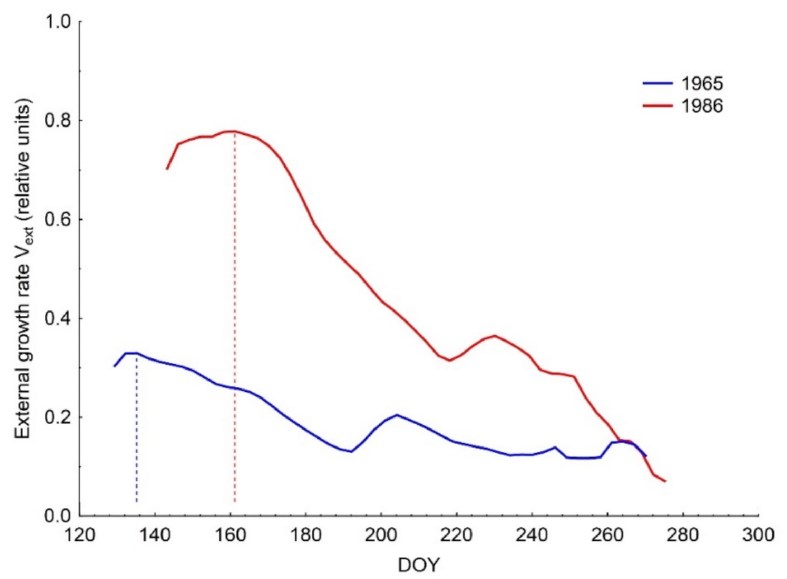
Figure 5. The 11-day moving average V ext growth rates for 1965 (blue curve) and 1986 (red curve). The simulations of seasonal cell production are obtained by the three day time unit for calculating ∆ L and 3three day average V ext as a threshold for V int , which were conse- quently applied over the growing seasons of the selected years (from respective SoS to EoS, Figure